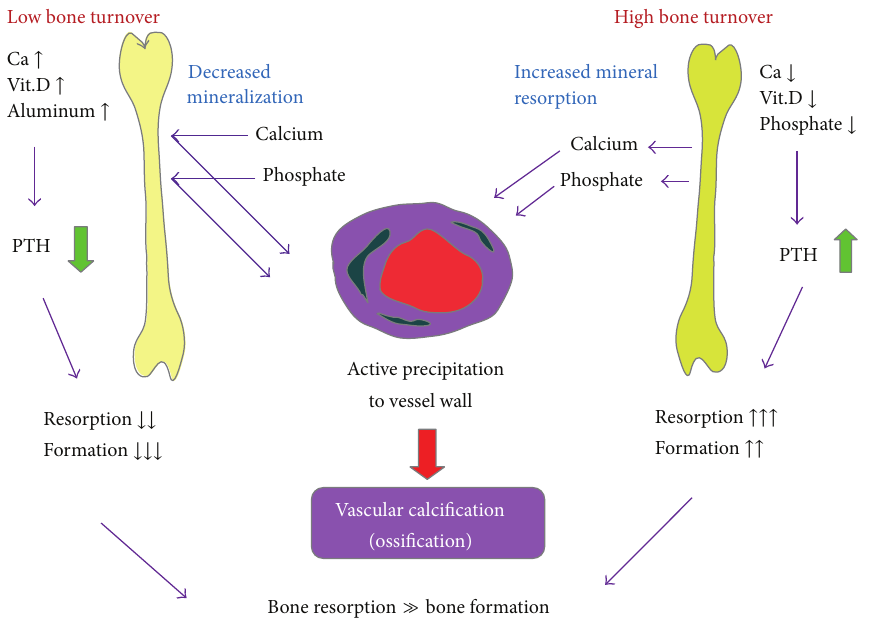
Figure 4: Bone turnover and vascular ossification in chronic kidney disease (CKD). Basically, bone cells have less vitality in patients with CKD than in normal persons. Thus, low bone turnover is part of the innate character of CKD. High PTH serum levels will overcome the indolent bone cells and lead to high turnover bone disease with the characteristics of relatively higher bone resorption than bone resorption. The high turnover status in SHPT can induce increased bone demineralization, which will increase calcium and inorganic phosphate release from bone into circulation. In contrast, overtreatment of CKD patients with Ca-salts, VDRA, or aluminum may cause them to develop low turnover bone disorders and low serum PTH levels. In patients with low bone turnover status, the decreased bone mineralization makes it difficult for calcium and inorganic phosphate to enter into bone, resultingin increased serum calcium and inorganic phosphate. Bothhigh and low bone turnover disorders are characterized by a relatively higher degree of bone resorption than bone formation, which may contribute to the elevated serum calcium and inorganic phosphate levels, and aggravate vascular